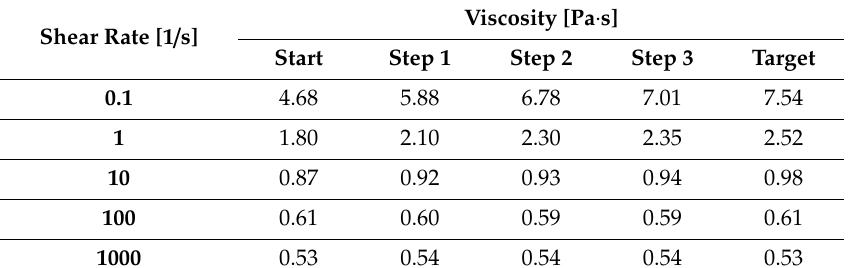
Table 1. Viscosity calculated off-line during the experiment carried out to validate the sensor and the support decision tool.